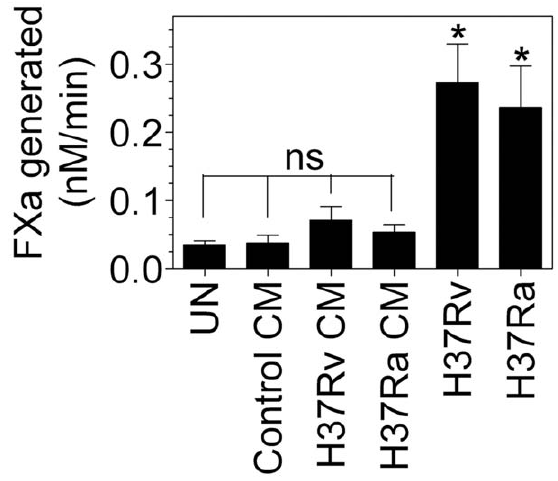
Figure 10. Autocrine signaling does not play a role for Mtb - mediated TF induction in macrophages. MDMs in 12-well plate were first infected with H37Rv or H37Ra (10 bacteria:1 cell ratio) in 1 ml RPMI complete medium without antibiotic. After overnight, condi- tioned medium (CM) was collected and passed through 0.22 m m filter. MDMs in 48-well plate derived from the same donor were then incubated with 0.25 ml of the conditioned medium or live bacteria (10 bacteria:1 cell ratio) in parallel for overnight. Thereafter, expression of TF activity at the cell surface was measured in factor X activation assay. ns, not statistically significant; * indicates significant difference compared to untreated control (P , 0.005). Data are mean 6 SEM (